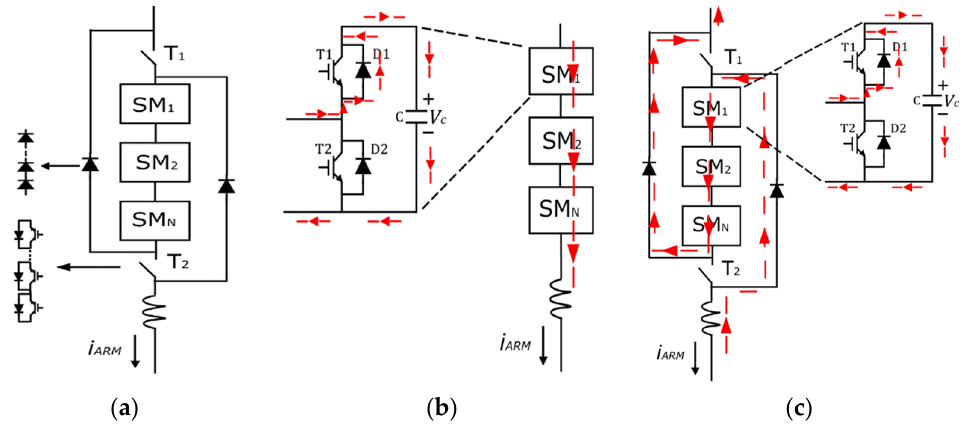
Figure 21. (a) Improved HBSM-based MMC arm; (b) fault current path through an arm for i ARM > 0; (c) fault current path through an arm for i ARM < 0.